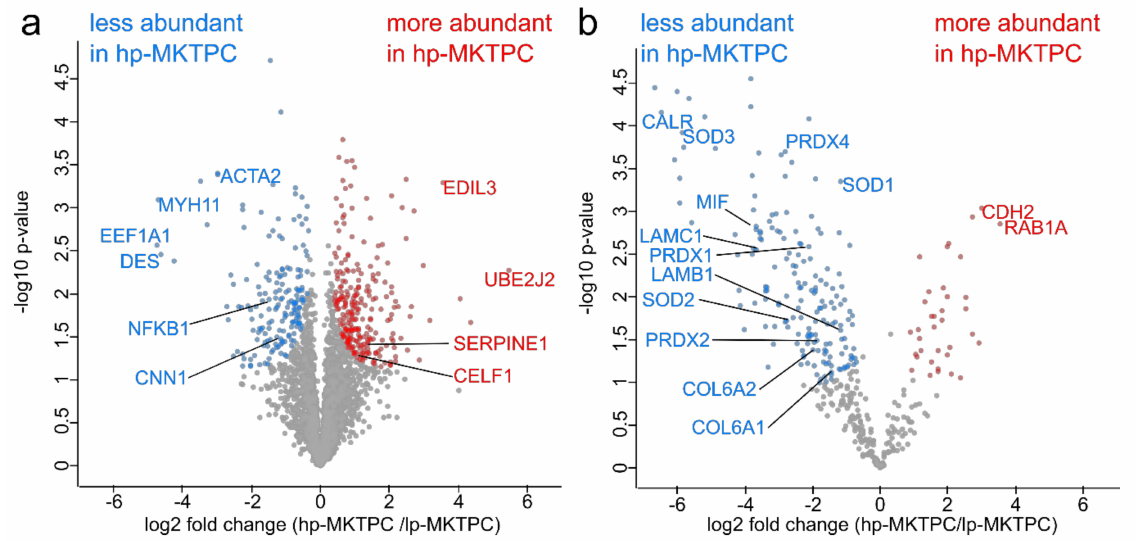
Figure 3. Volcano plots of hp-MKTPC vs. lp-MKTPC proteomes ( a ) and secretomes ( b ). For statistics, a paired Welch t -test was used. Results were corrected for multiple testing with a false discovery rate (FDR) of 0.05. Each colored dot represents a di ff erentially abundant protein fulfilling the significance